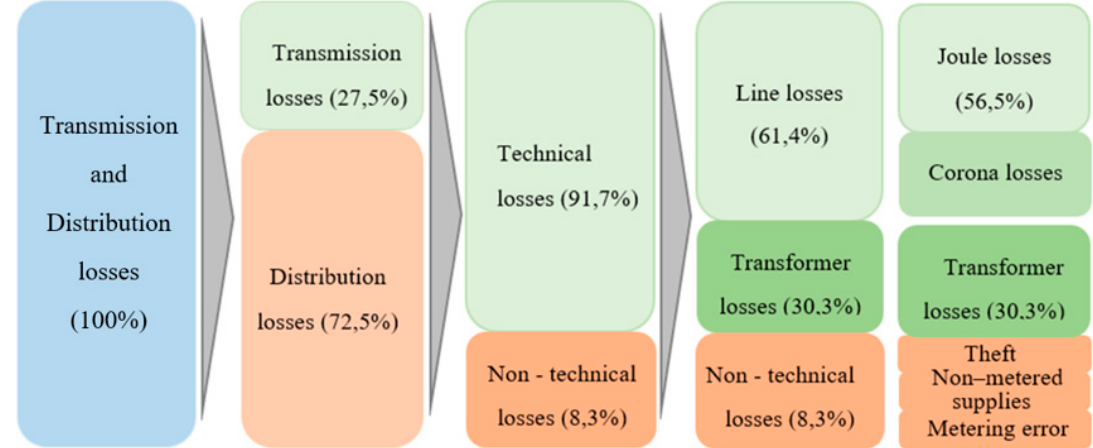
Figure 2. Components of T&D losses and their shares in total energy losses (adopted from [3], 2017, CPESE).